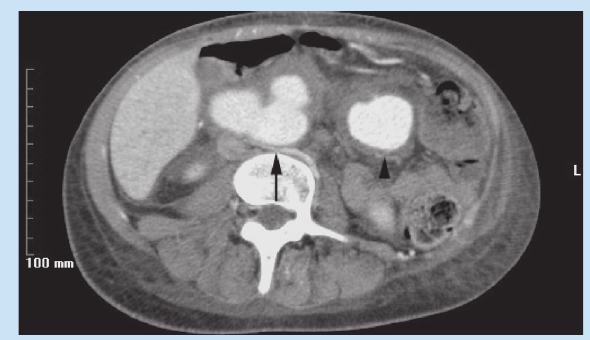
Fig. 3. CT angiogram inferior to Fig. 2 indicating aneurysmal superior mesenteric artery (arrowhead) and abdominal aorta (arrow).